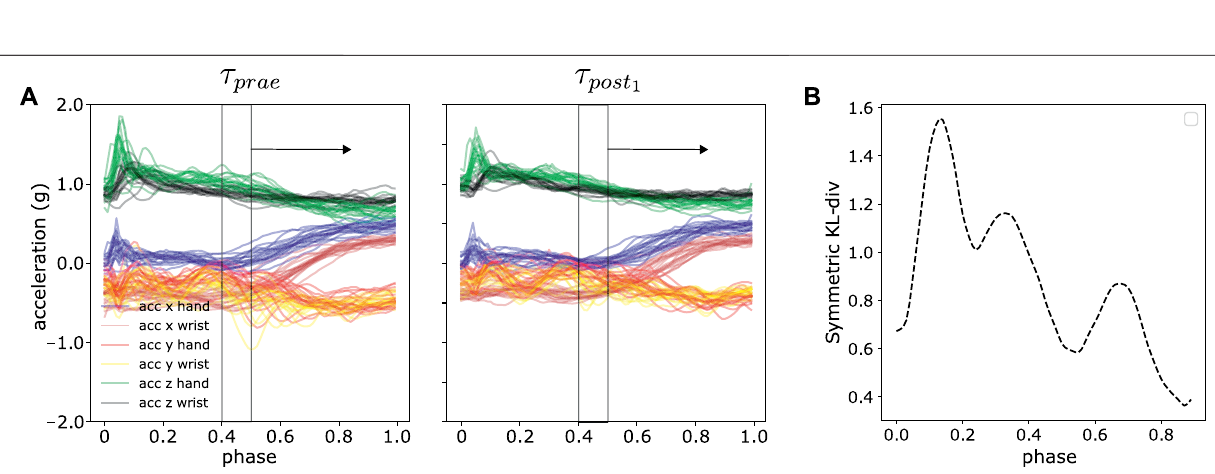
FIGURE 10 | This Figure shows the D KLS value of experiment subject 2 for each stimulation approach, each experiment con fi guration and each post-stimulation phase. The D KLS are computed from the outward movements. The x-axis denotes the comparison between post-stimulation phase Post and non-stimulated phase Prae . The statistics already excludes the outliers via the 3 σ rule mentioned in Section 5.3. As the D KLS is quite low, no signi fi cant effect of tACS, tRNS and tDCS over the hand motion can be observed in this